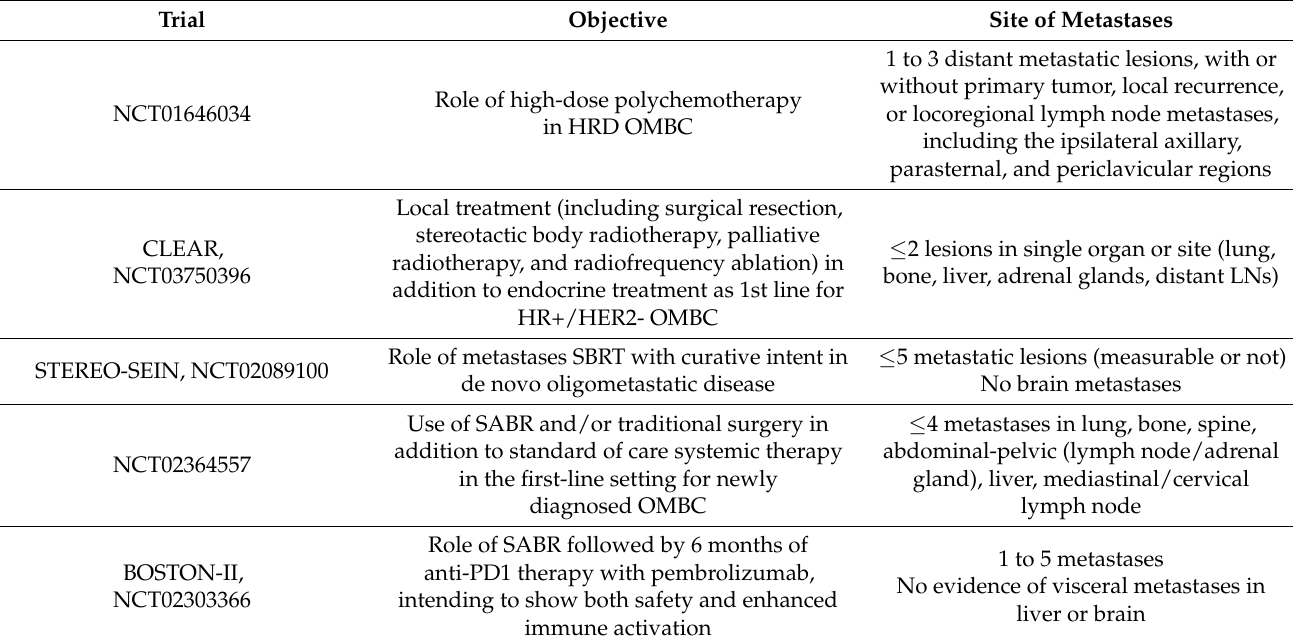
Table 3. Ongoing trials in oligometastatic